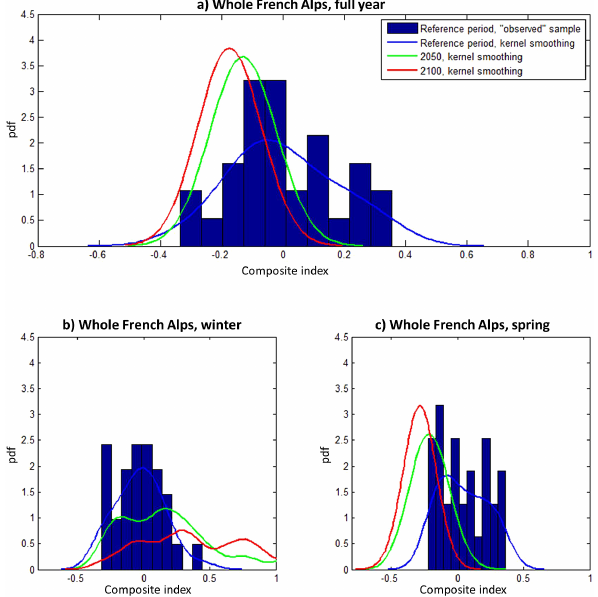
Figure 3. Probability density functions of the annual and seasonal means of the CI regression model over the reference period and in 2020–2050 and 2070–2100. The entire French Alps are considered, during the full avalanche year (a) and during the winter (b) and spring (c)